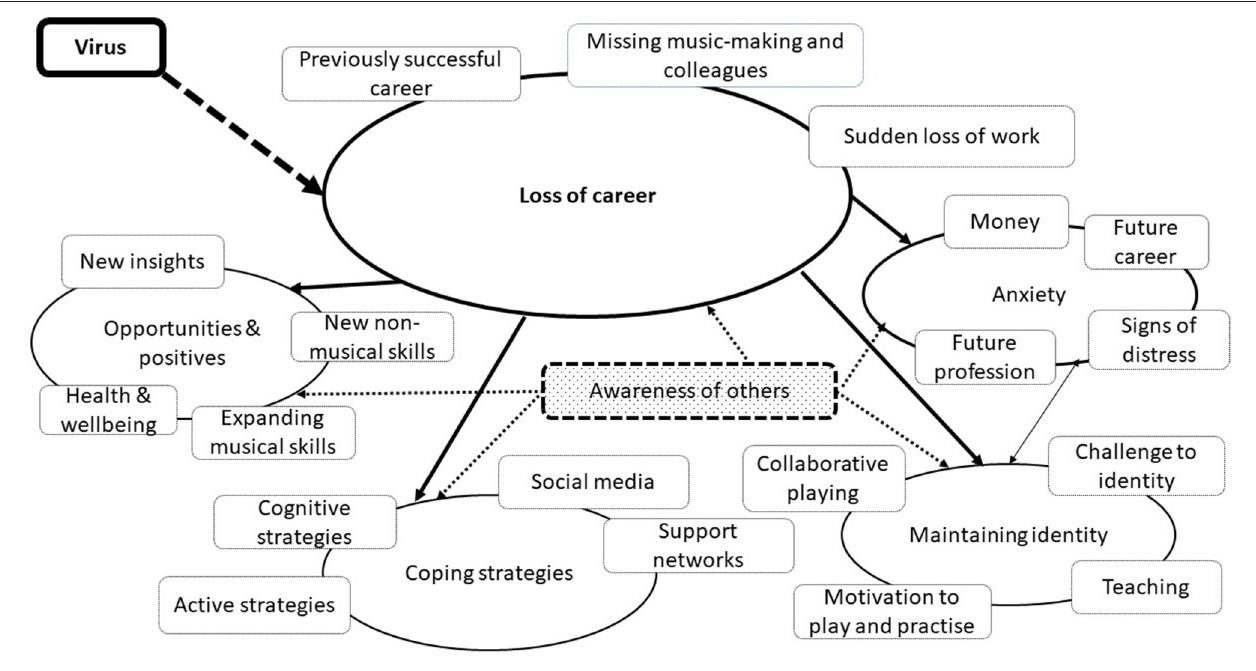
FIGURE 1 | Model of themes and overarching themes.